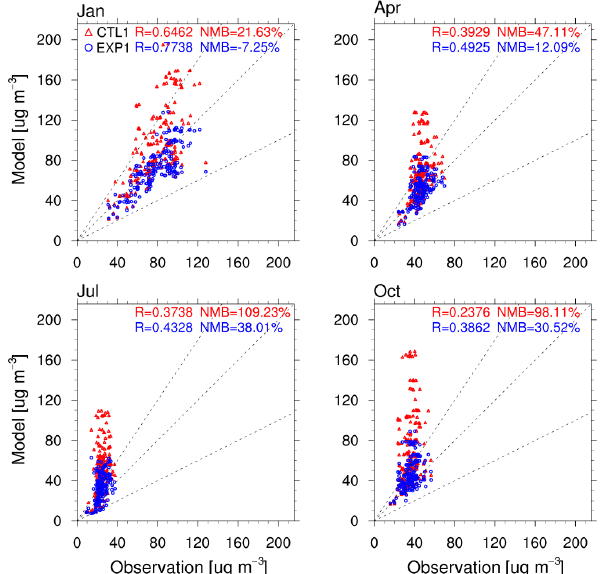
Figure 12. Comparison of monthly mean surface PM 2 . 5 concen- trations between the observations and the simulations from experi- ments CTL1 and EXP1 at each observation site over the YRD re- gion of East China (as shown in Fig. 1a within the black box) for January, April, July, and October of 2018. The dashed lines repre- sent − 50%, 0%, and 50% of the NMB of simulation.